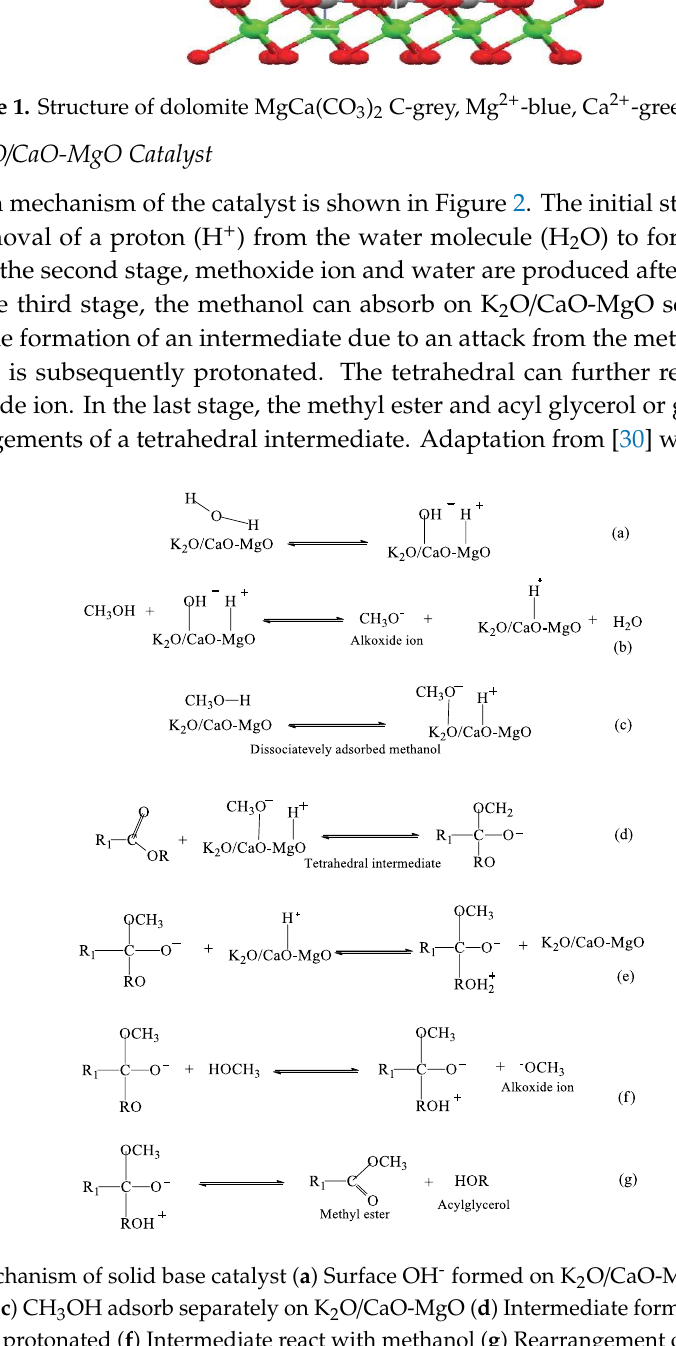
2 + -blue, Ca 2 + -green, O 2 − -red. 3 ) 2 C-grey, Mg